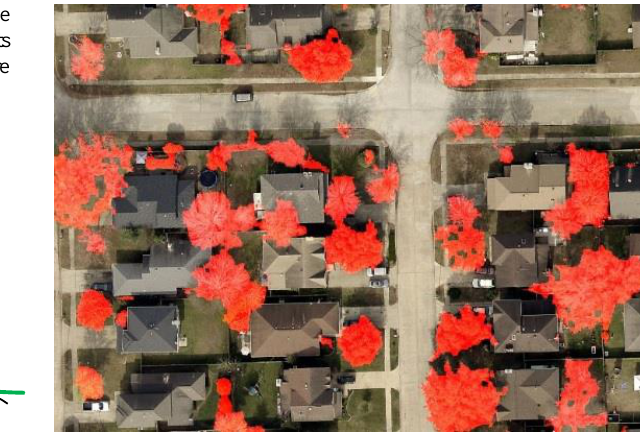
Figure 2 Automatic Generation of Bare-earth Surface